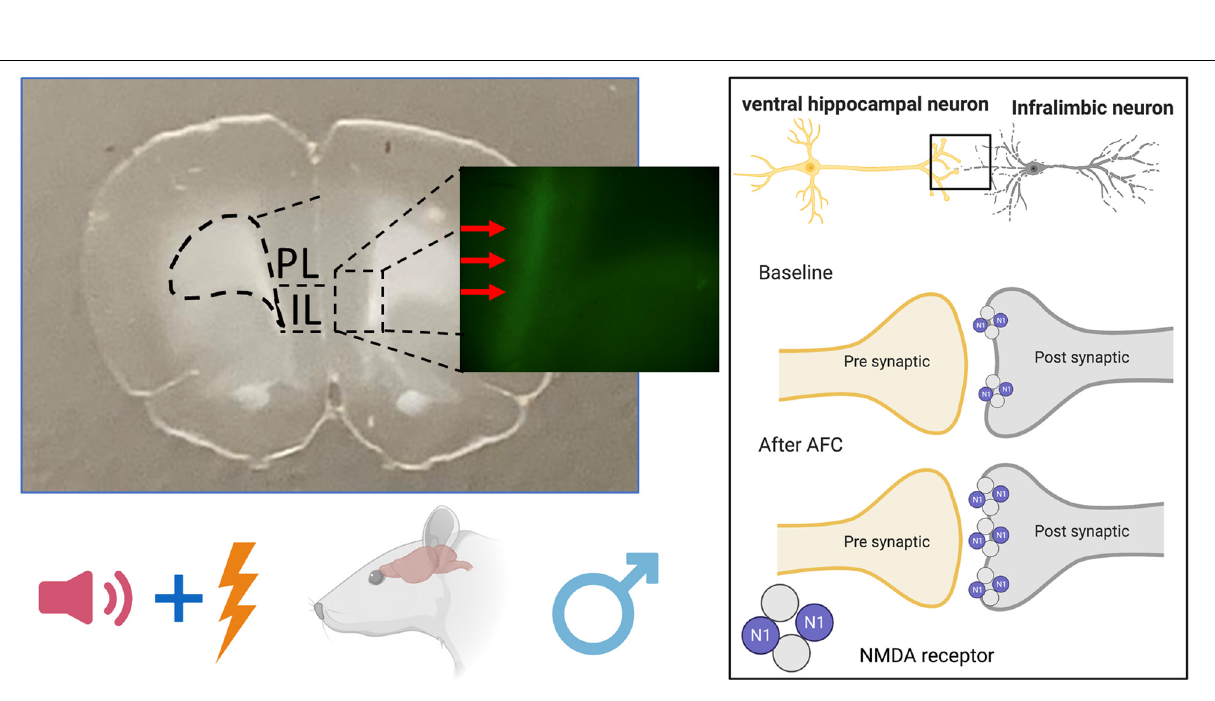
Frontiers in Synaptic Neuroscience |